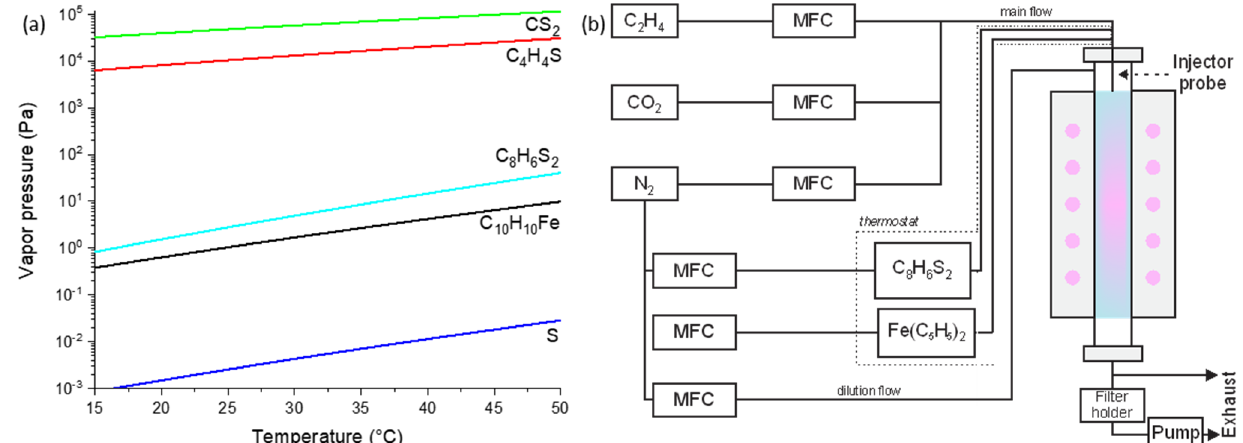
Figure 1. ( a ) Equilibrium vapor pressures of 2,2 ′ -bithiophene (C 8 H 6 S 2 ; cyan line), thiophene (C 4 H 4 S; red), sulfur (S; blue), carbon disulfide (CS 2 ; green), and ferrocene (FeC 10 H 10 ; black), [36]; ( b ) a scheme for the aerosol CVD reactor used in the work (MFC stands for a mass- fl ow controller; chemical formulas for the vessels/units fi lled with corresponding species).